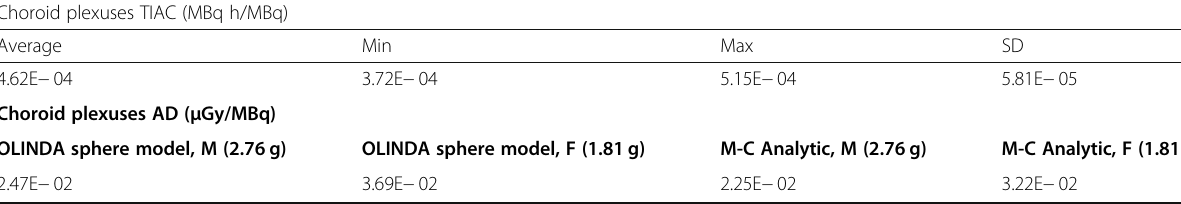
Table 4 Dosimetry assessment in choroid plexuses. The average TIAC value was used in input to the OLINDA/EXM sphere model and to the Monte Carlo-derived analytical model